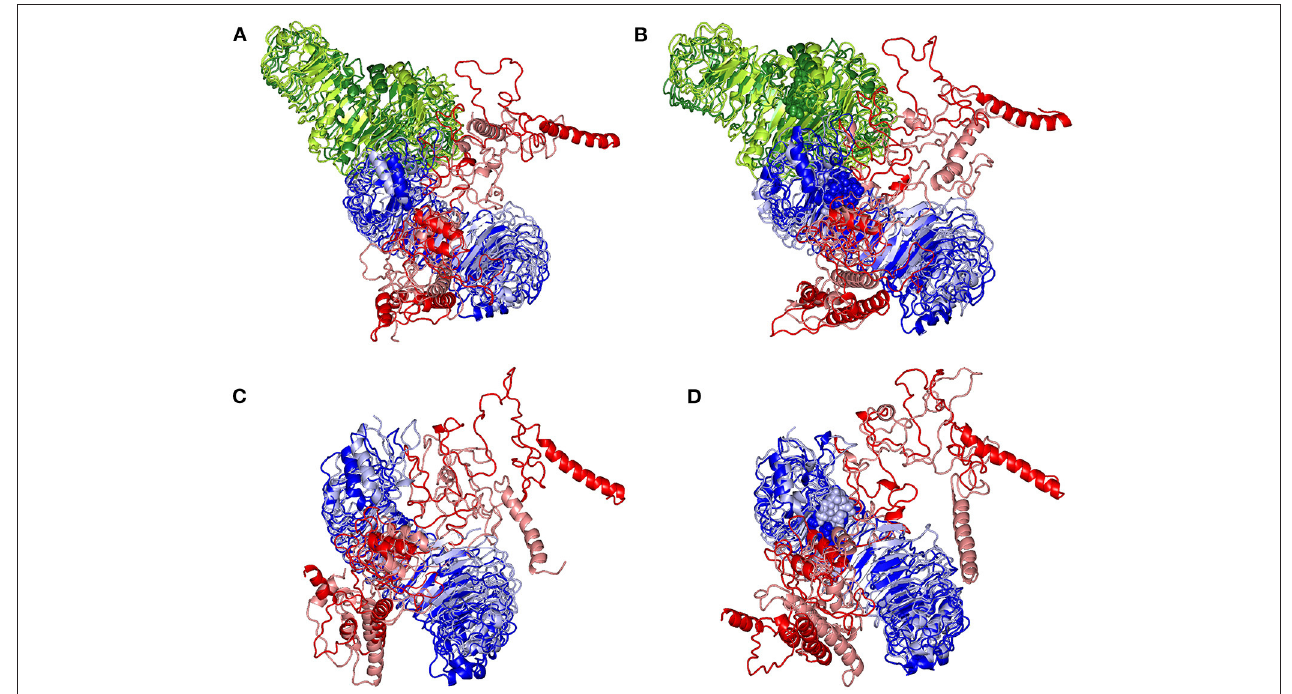
FIGURE 9 | Conformational changes for the simulated h TLR-4/epitope vaccine complexes. Overlaid snapshots of the 3D-cartoon representation of the; (A) glycosylated dimeric, (B) non-glycosylated dimeric, (C) glycosylated monomeric, and (D) non-glycosylated monomeric states at 0 ns and 100 ns of the molecular dynamics runs. The h TLR-4 target proteins (blue/green) and epitope vaccine ligands (red) are colored in respective to the initial or last extracted frames (dark and light colors are for 0 ns and 100 ns extracted frames, respectively). Moieties of N -glycosylation are presented as spheres and colored in respective to their linked h TLR-4 protomer and extracted frame.